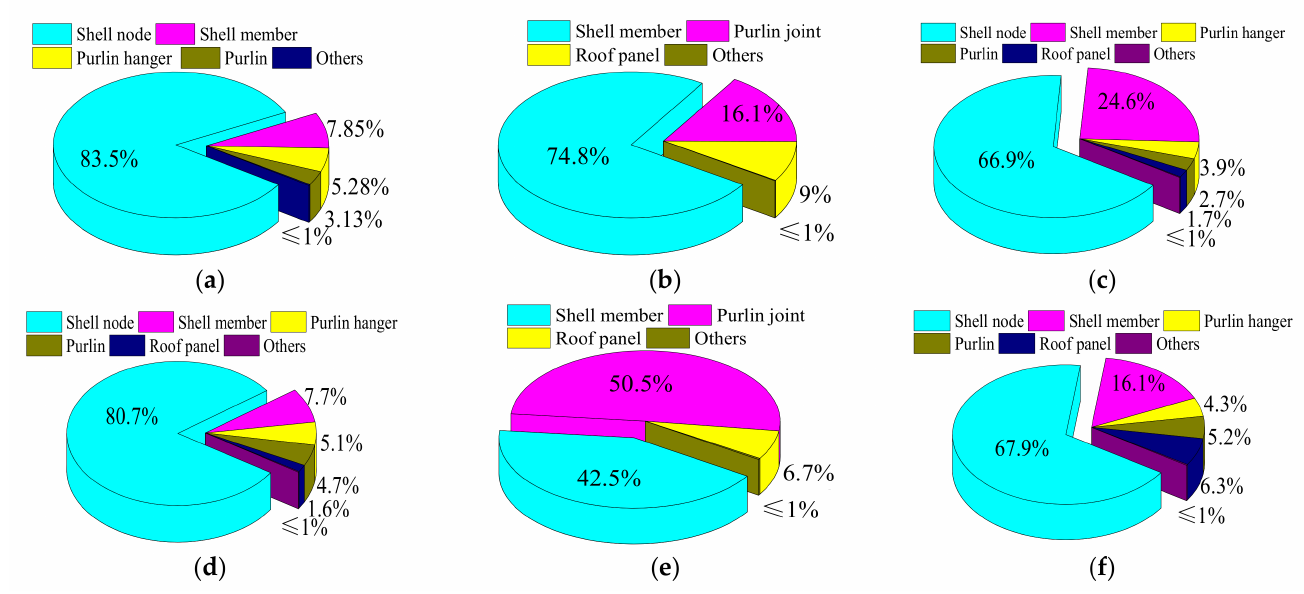
Figure 8. Energy dissipation distributions of the components in the shells: ( a ) D4053-LSWM 2200 cm/s 2 kinetic energy; ( b ) D4053-LSWM 2200 cm/s 2 deformation energy; ( c ) D4053-LSWM 2200 cm/s 2 damping energy consumption; ( d ) D4053-HHWM 2800 cm/s 2 kinetic energy; ( e ) D4053- HHWM 2800 cm/s 2 deformation energy; ( f ) D4053-HHWM 2800 cm/s 2 damping energy